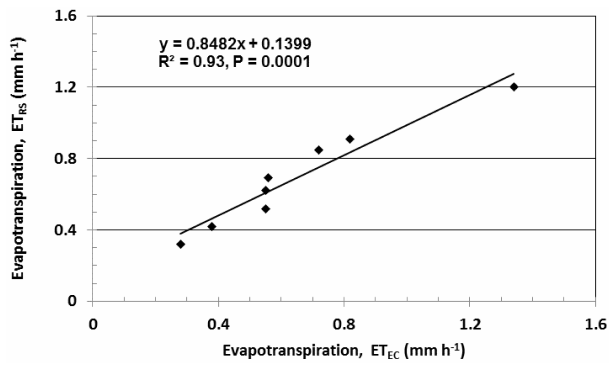
Figure 6. LAI and G/R n relationship of the study crop for remote sensing (RS) and eddy covariance (EC). Figure 7. METRIC-derived hourly evapotranspiration (ET RS ) ver- sus eddy covariance measurements (ET EC ) .